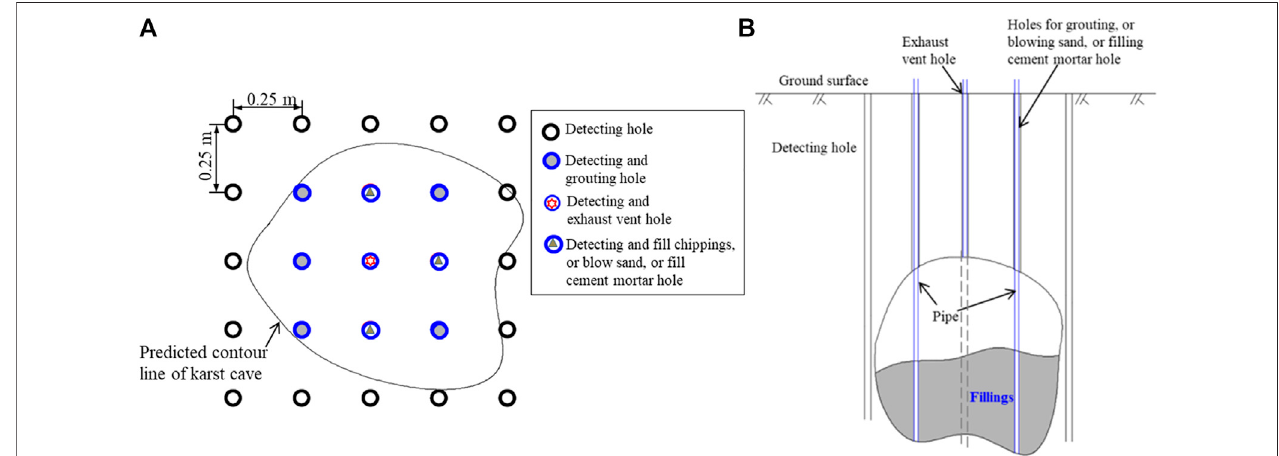
FIGURE 9 | (A) Arrangement of drilling holes; (B) pro fi le map.